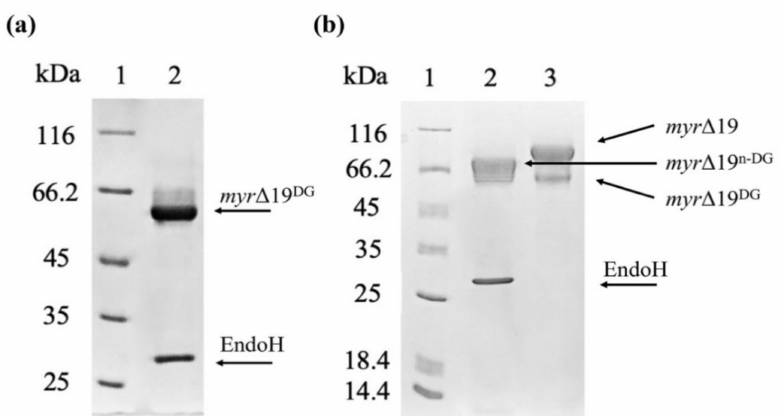
Figure 5. The deglycosylation of a purified myrosinase ( myr - ∆ 19) with EndoH. ( a ) SDS-PAGE analy- sis of myrosinase deglycosylation under denaturing conditions: lane 1—molecular weight marker; lane 2—deglycosylated myrosinase ( myr - ∆ 19 DG ). ( b ) SDS-PAGE analysis of myrosinase deglycosyla- tion under non-denaturing conditions: lane 1—molecular weight marker; lane